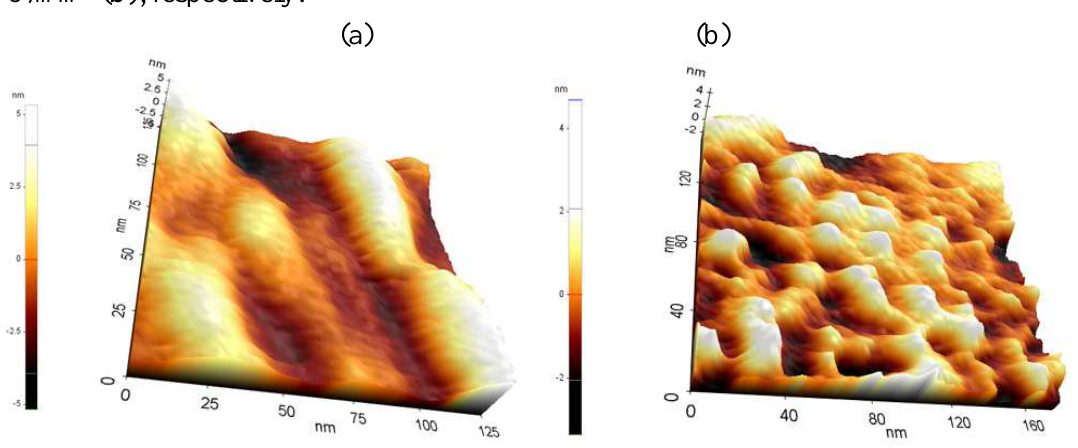
Figure 3. AFM images of fabricated nanoporous Pt at charge at 35 mC/mm 2 ( a ) and 65 mC/mm 2 ( b ),